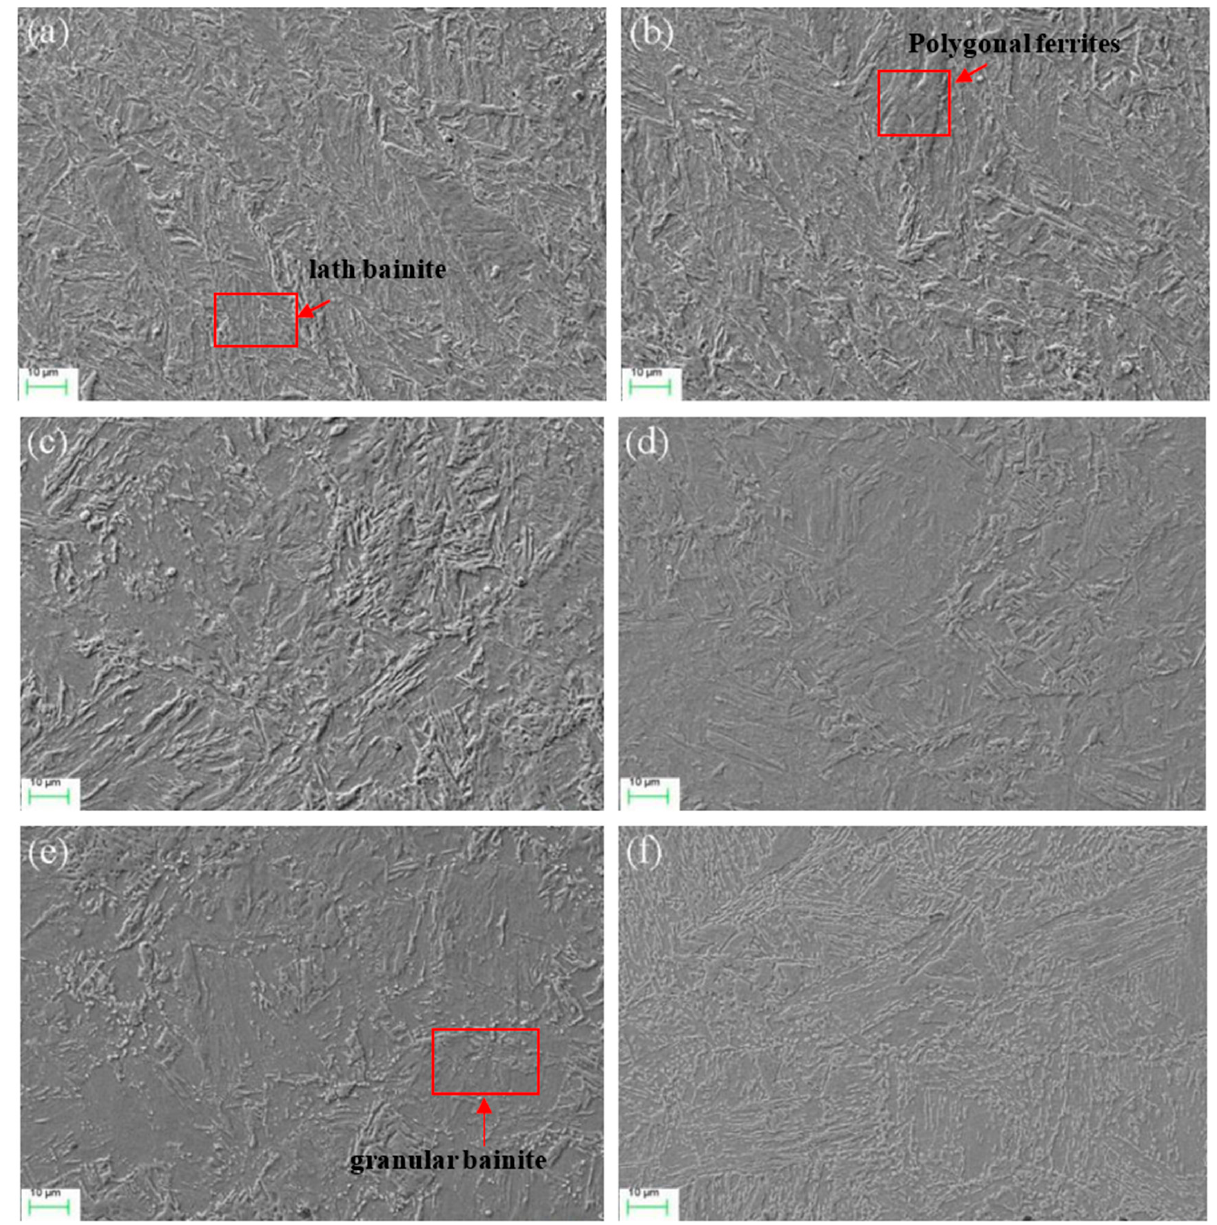
Figure 4. SEM images of N2 steel tempered at: ( a ) 450 °C; ( b ) 500 °C; ( c ) 550 °C; ( d ) 600 °C; ( e ) 650 °C; ( f ) 700 °C.